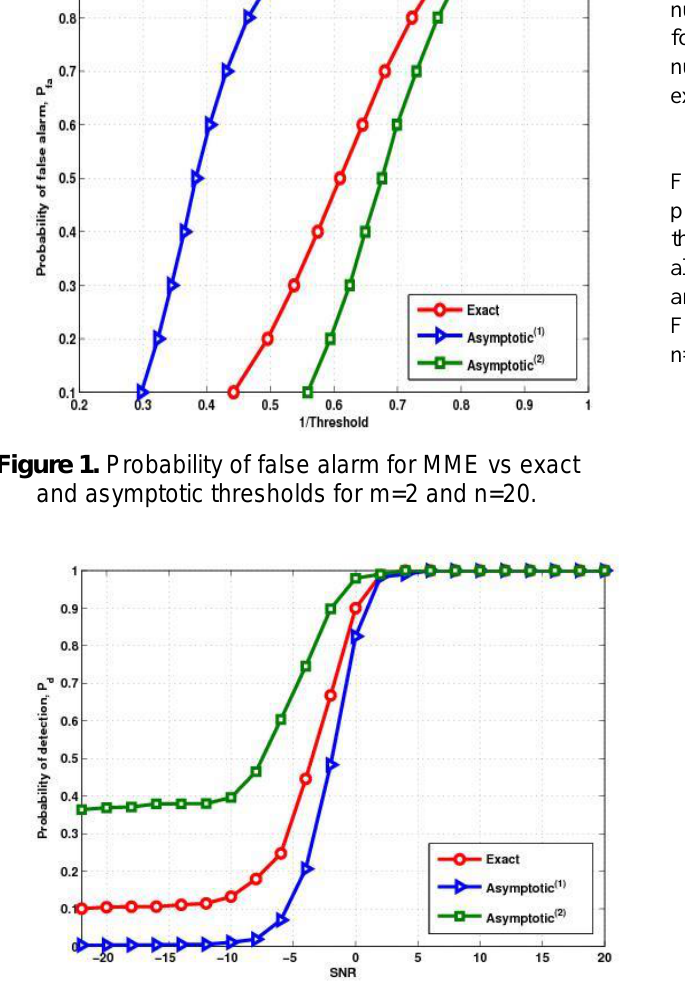
Figure 2. Probability of detection for MME vs SNR